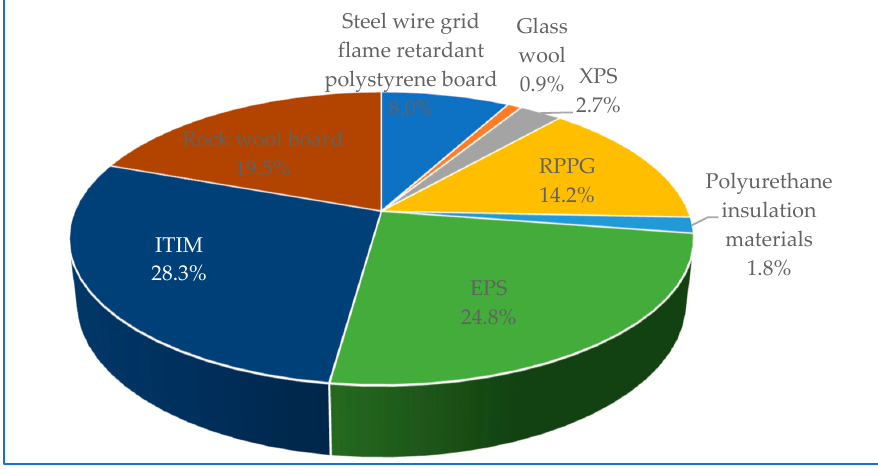
Figure 6. Proportion of each type of ETICS.